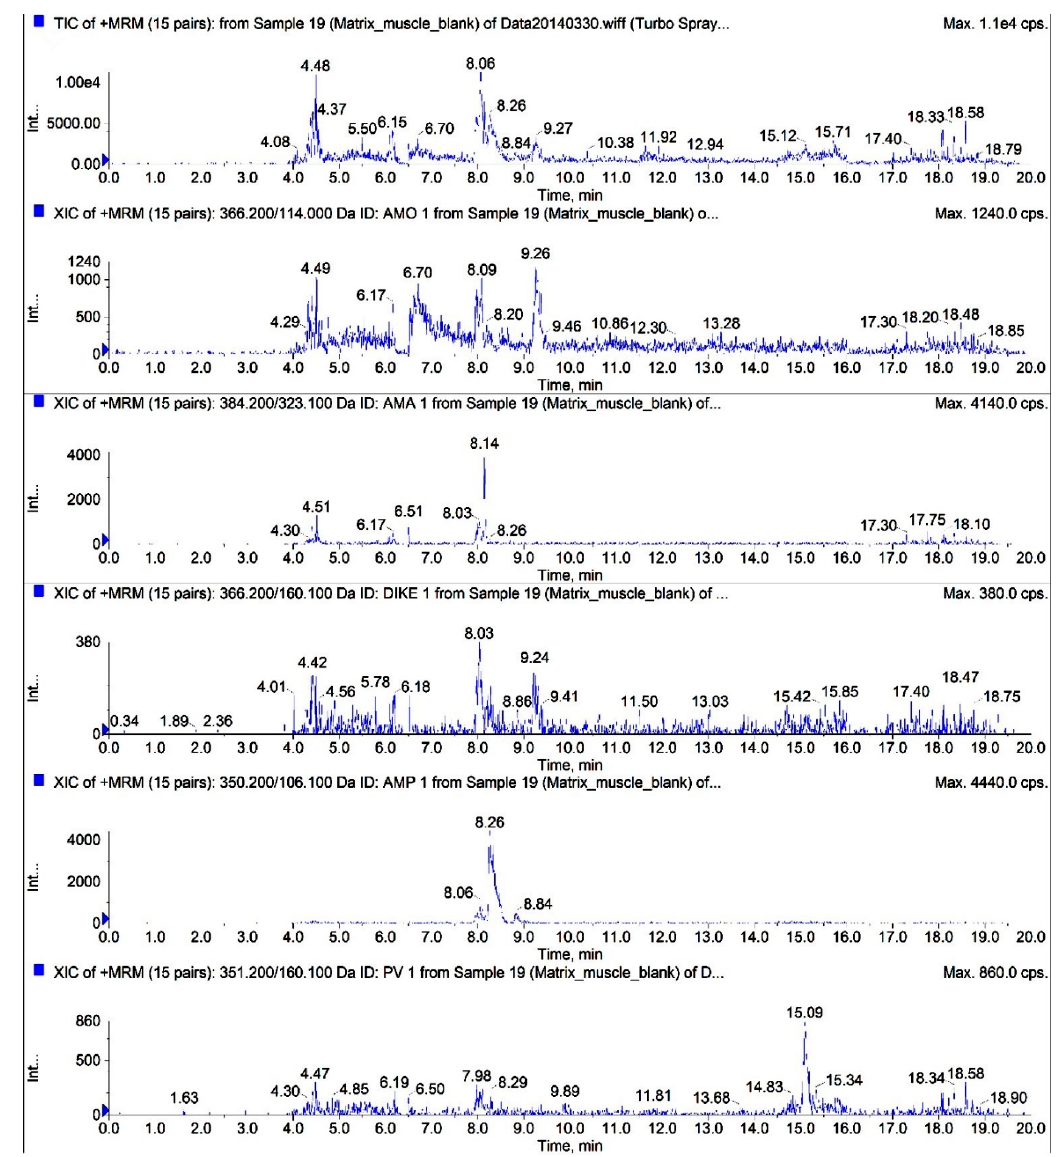
Figure 2. Total ion chromatograms (TICs) and extracted ion chromatograms (XICs) of AMO, AMA, DIKETO, AMP, and PV in blank chicken muscle samples.